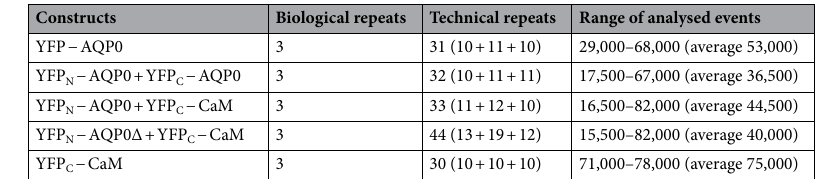
Table 1. Experimental setup for the evaluation of fluorescence intensity and relative YFP frequency of BiFC complexes. Number of biological repeats (independent transformation event) and technical repeats are shown for each construct. The range and average of events analyzed in each measurement are